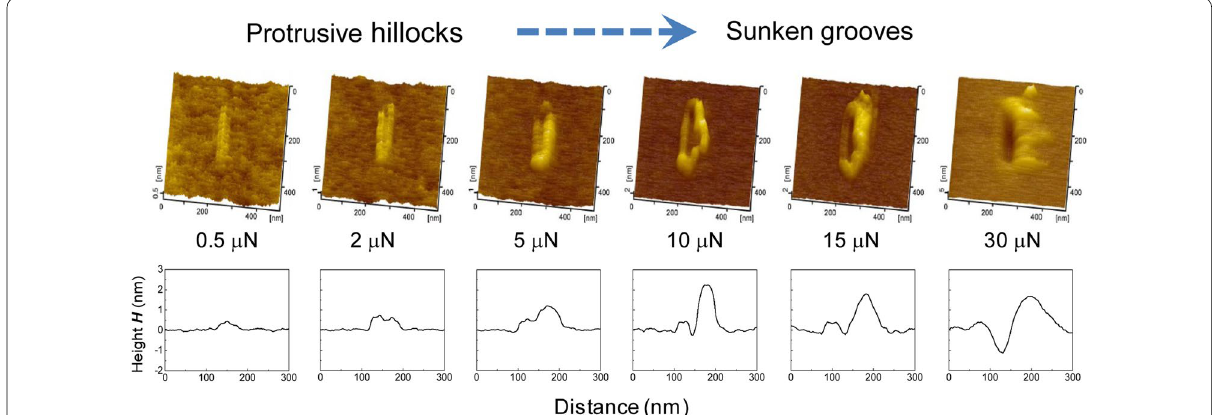
Figure 4 AFM images (top) and cross-sectional profiles (bottom) of the scratches on Si(100) surface after line-scratching under various normal load F n [36] (The diamond tip for the test has tip radius of about 0.15 μm, D